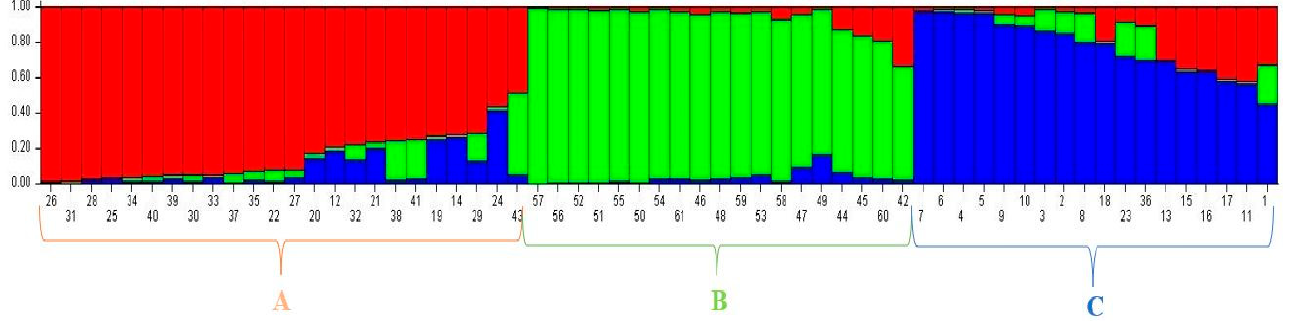
Table 7. Genetic differentiation based on Fst values among forage pea ( P. sativum ssp. arvense L.) landrace accession sub-populations identified by population structure analysis.